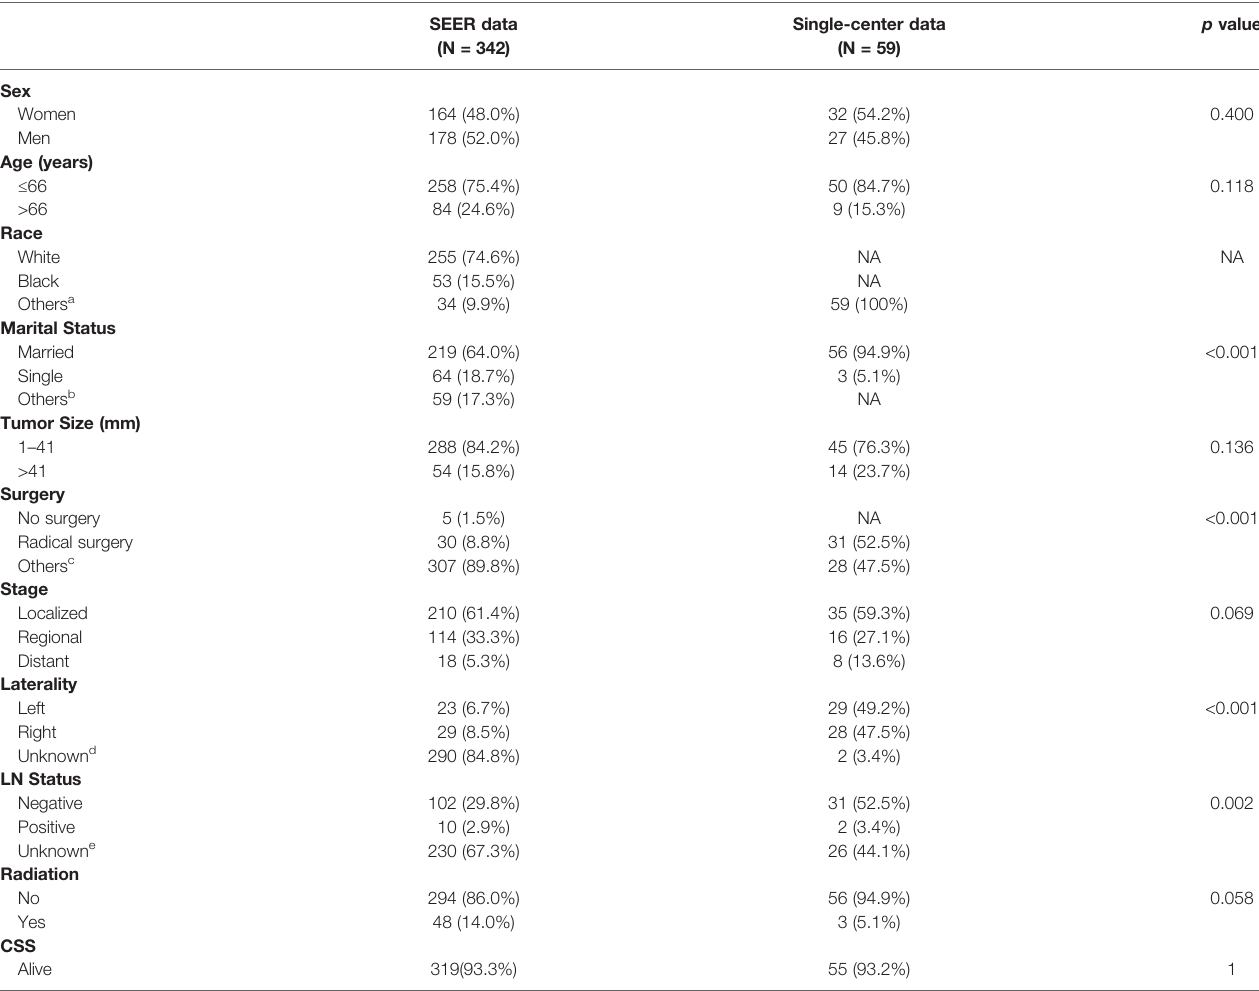
TABLE 1 | Demographic and clinical characteristics in the SEER database and a single Chinese center*. SEER